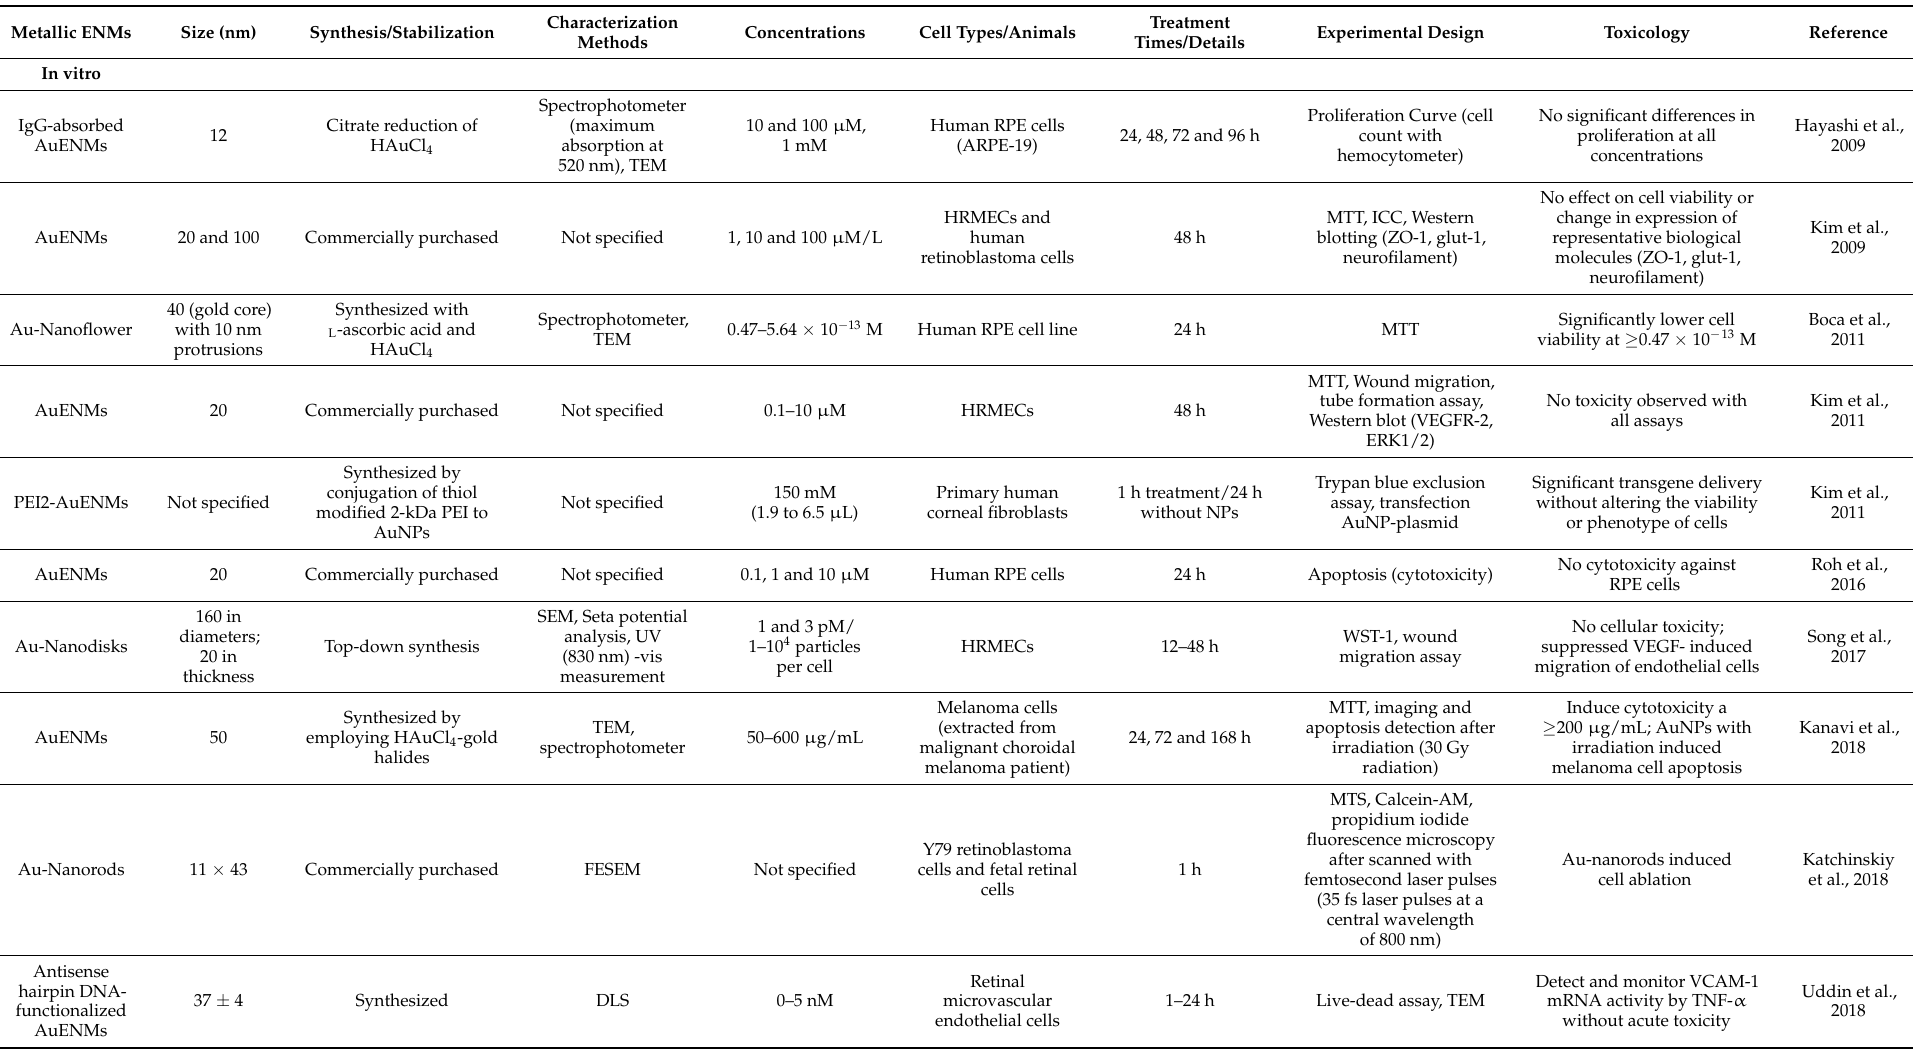
Table 1. Published studies utilizing gold nanoparticles (AuENMs) in